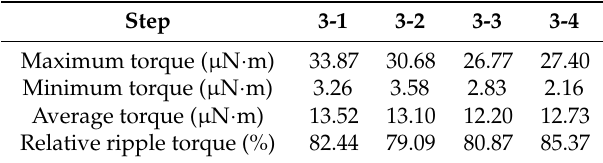
Table 4. Step 3: Comparison of the torque characteristics of each step.